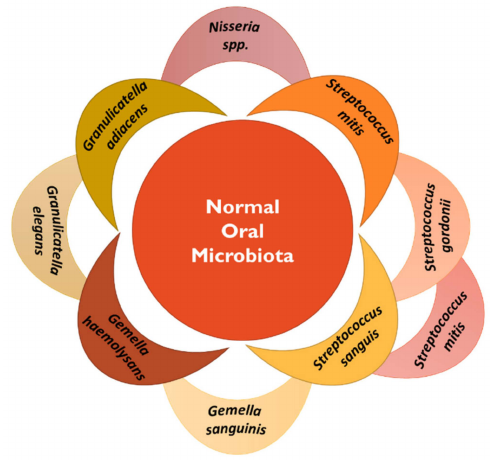
Figure 3. Summary of the microbial species present in the normal oral microbiota